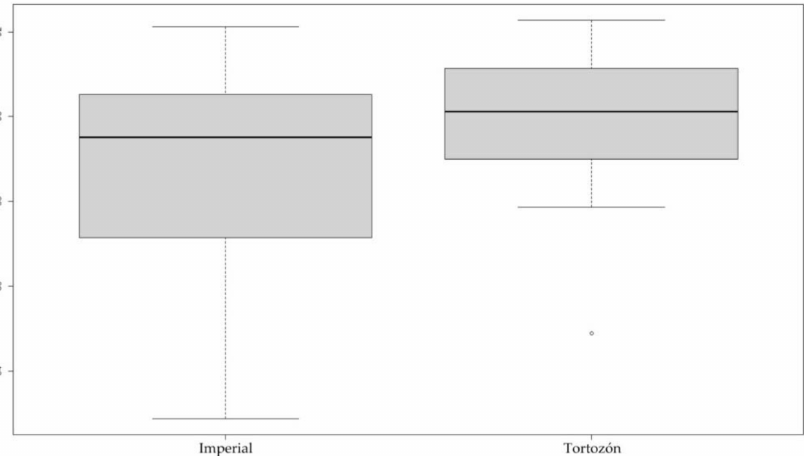
Figure 15. Box-plot representations showing the distribution of J index values in cultivars Imperial and Tortoz ó n with the Tortoz ó n